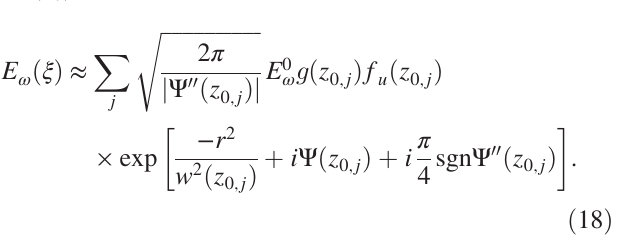
FIG. 3. Typical variation of g ð z Þ and k ð z Þ σ 2 undulator for two trial tapers f referred to as the positive and negative ones. The bunch and undulator parameters are discussed in detail in Sec.